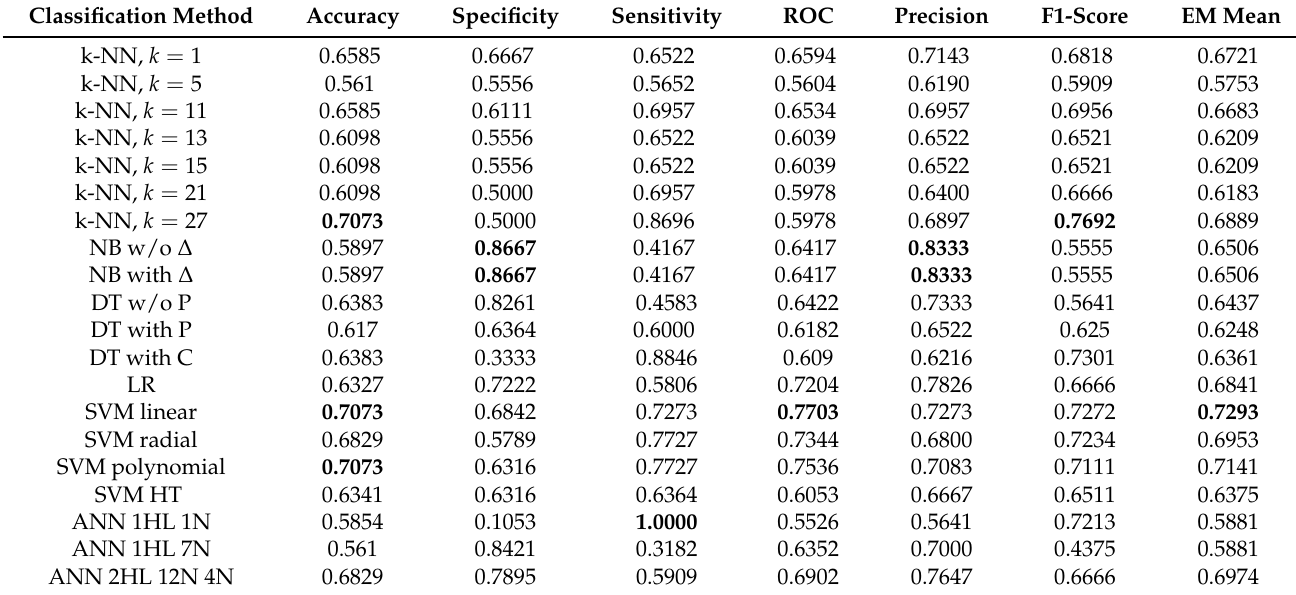
Table 1. Evaluation metrics for each classifier of the original